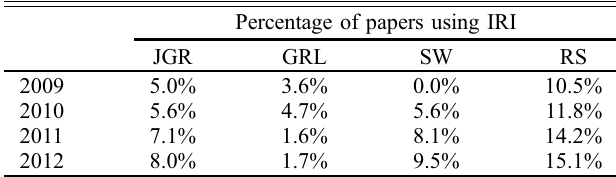
Table 3. Percentage of JGR, GRL, SW, and RS papers using IRI. Percentage of papers using IRI